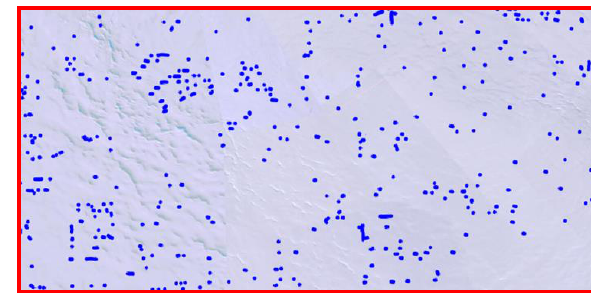
Figure 8 . Extraction result of proposed method.